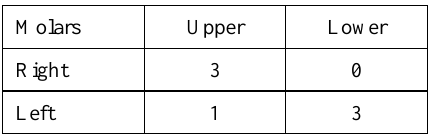
Table 1. Combined 3D models of